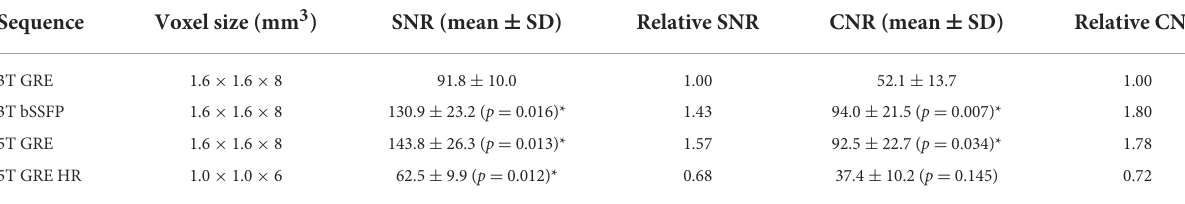
TABLE 3 Comparison on SNR and CNR of SAX images, using 3T GRE as reference. Sequence